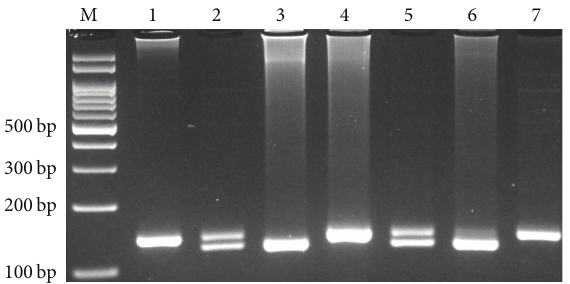
Figure 2: Photograph of the PCR products of HLA-G 14 bp ins/del polymorphism by polymerase chain reaction (PCR). Product sizes were 127 bp for del and 141bp for ins allele. M: DNA Marker; Lanes 1, 4, and 7: ins/ins; Lanes 2 and 5: ins/del; Lanes 3 and 6: del/del.